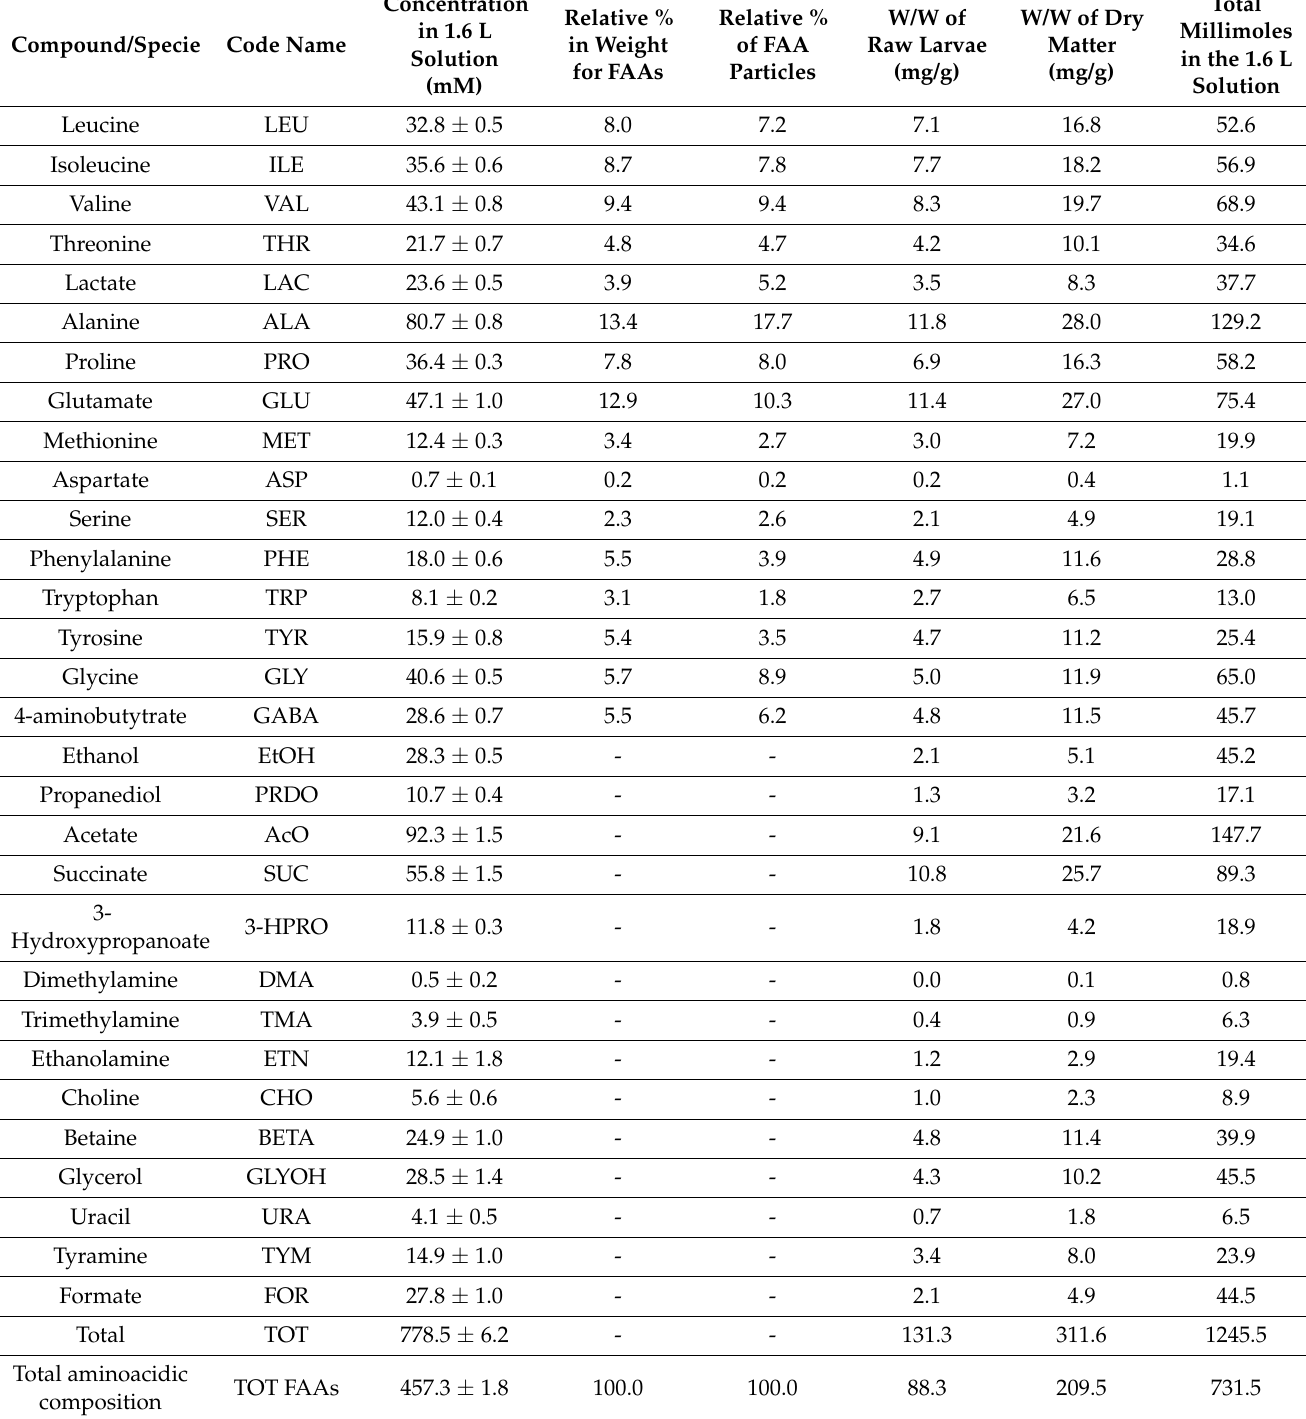
Table 2. Quantification of metabolites obtained with the large-scale production, with specific regard to the free aminoacidic composition. Different quantification units are displayed for an easy comparison with other similar